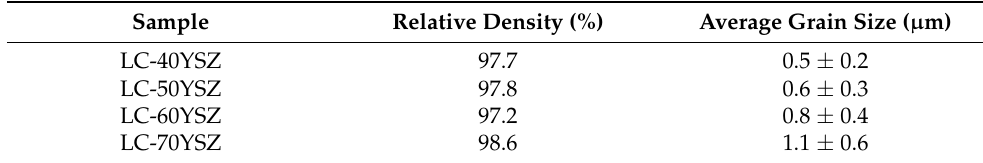
Table 2. Relative densities and average grain sizes of the investigated LC-YSZ bulk samples sintered at 1400 ◦